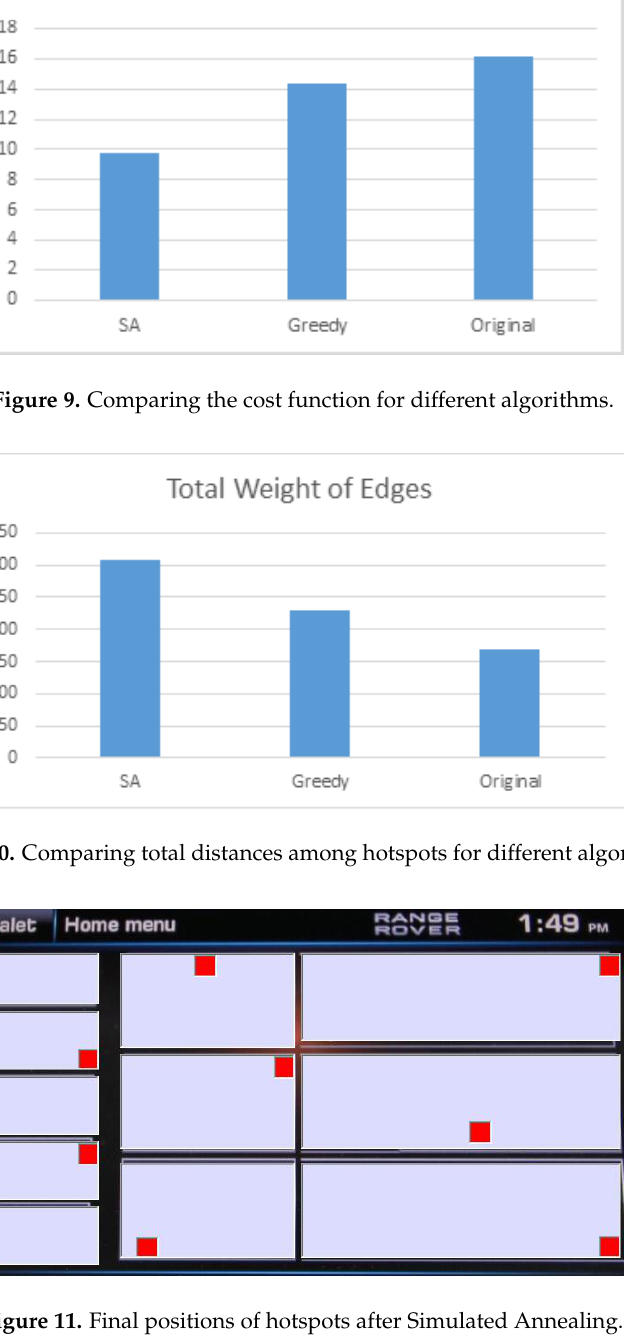
Figure 12. Hotspots for a representative MultiFunction Display. The hotspot drawing algorithm can be extended to any interface that has clickable items big enough to house a hotspot. However, hotspots will not work if clickable items are small and closely packed like a virtual keyboard. 4. User Study The contributions of this paper are: 